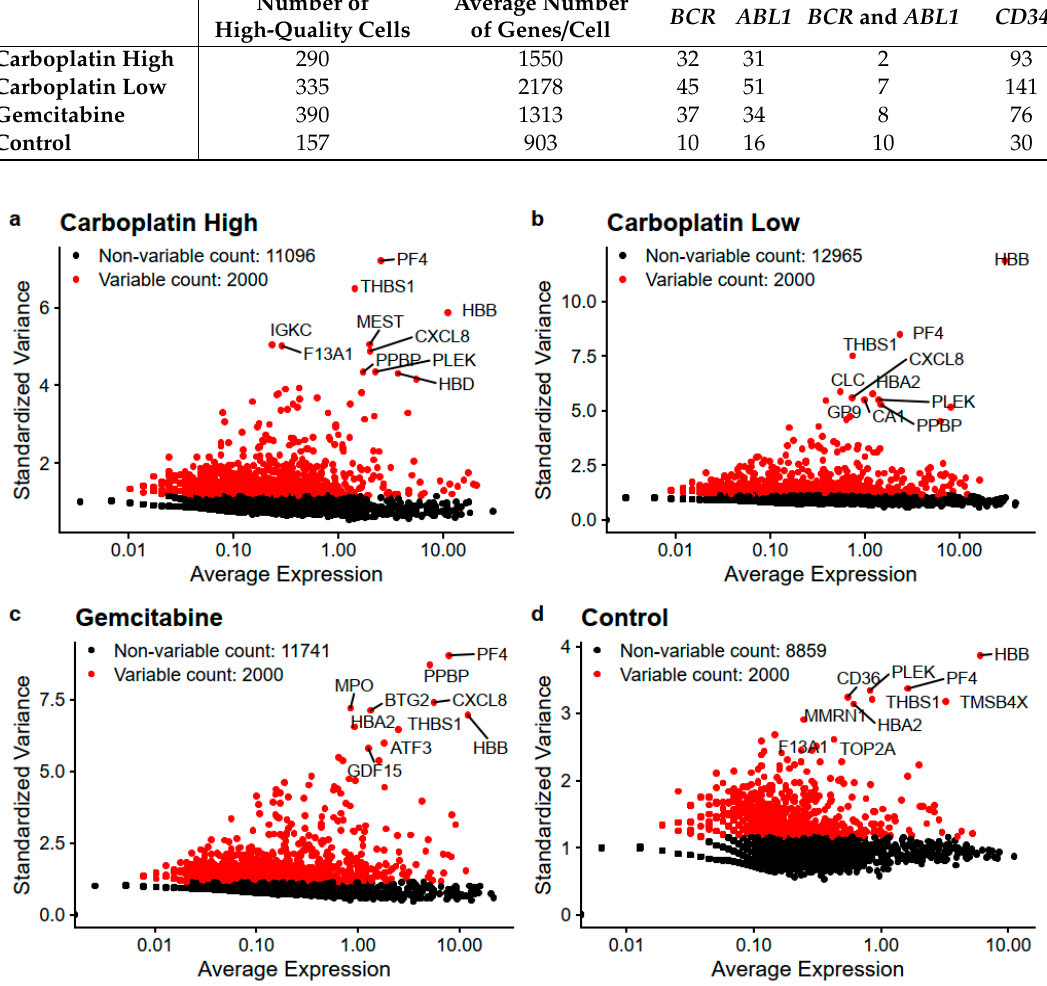
Figure 2. Depicts the most variable genes for ( a ) Carboplatin High, ( b ) Carboplatin Low, ( c ) Gemcitabine, and ( d ) Control. The ten genes with the highest standardized variance are written out for each sample. Table 3. The 25 most variable genes for Carboplatin High, Carboplatin Low, Gemcitabine, and